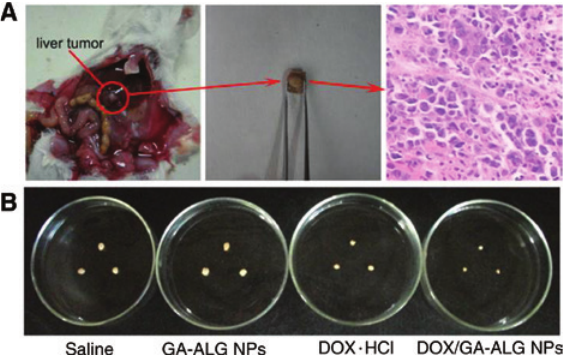
Figure 5: DOX released from DOX/GA-ALG NPs was pharmacologi- cally active and therefore able to target and induce cell death in tumor cells. Both DOX/GA-ALG NPs and DOX⋅HCl suppress tumor growth compared with the saline group, and DOX/GA-ALG NPs exhibited the greatest antitumor effects. (A) Image of Kunming mice bearing H22 liver tumor in situ and a tissue slice of liver tumor in situ. (B) Representative photographs of excised H22 tumors in situ from mice treated with saline, GA-ALG NPs, DOX⋅HCl and DOX/ GA-ALG NPs. Reprinted from Zhang et al. [73]. Copyright (2012), with permission from